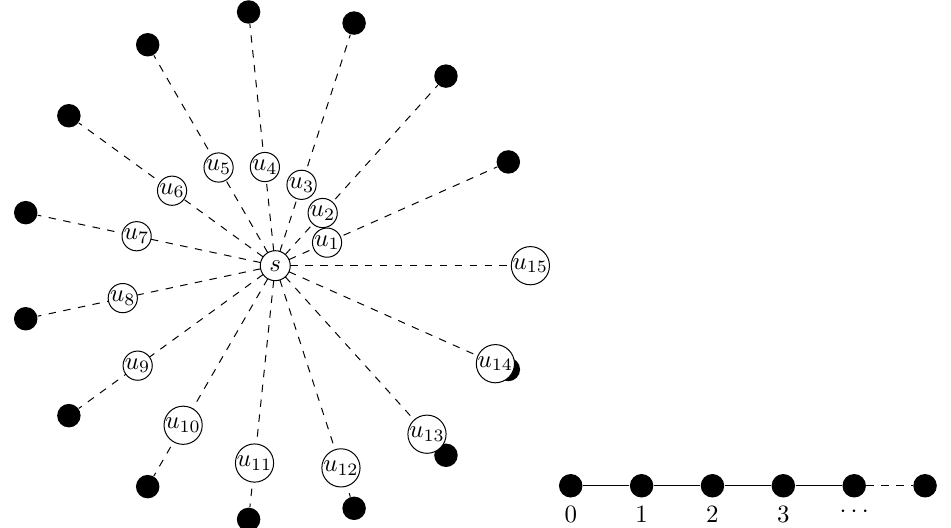
Figure 5. Synthetically generated graphs considered in Sections 6.4.1 and 6.4.2. Dashed lines visualize simple paths. On the left, the query vertex s is in the center, and assign each vertex an index by